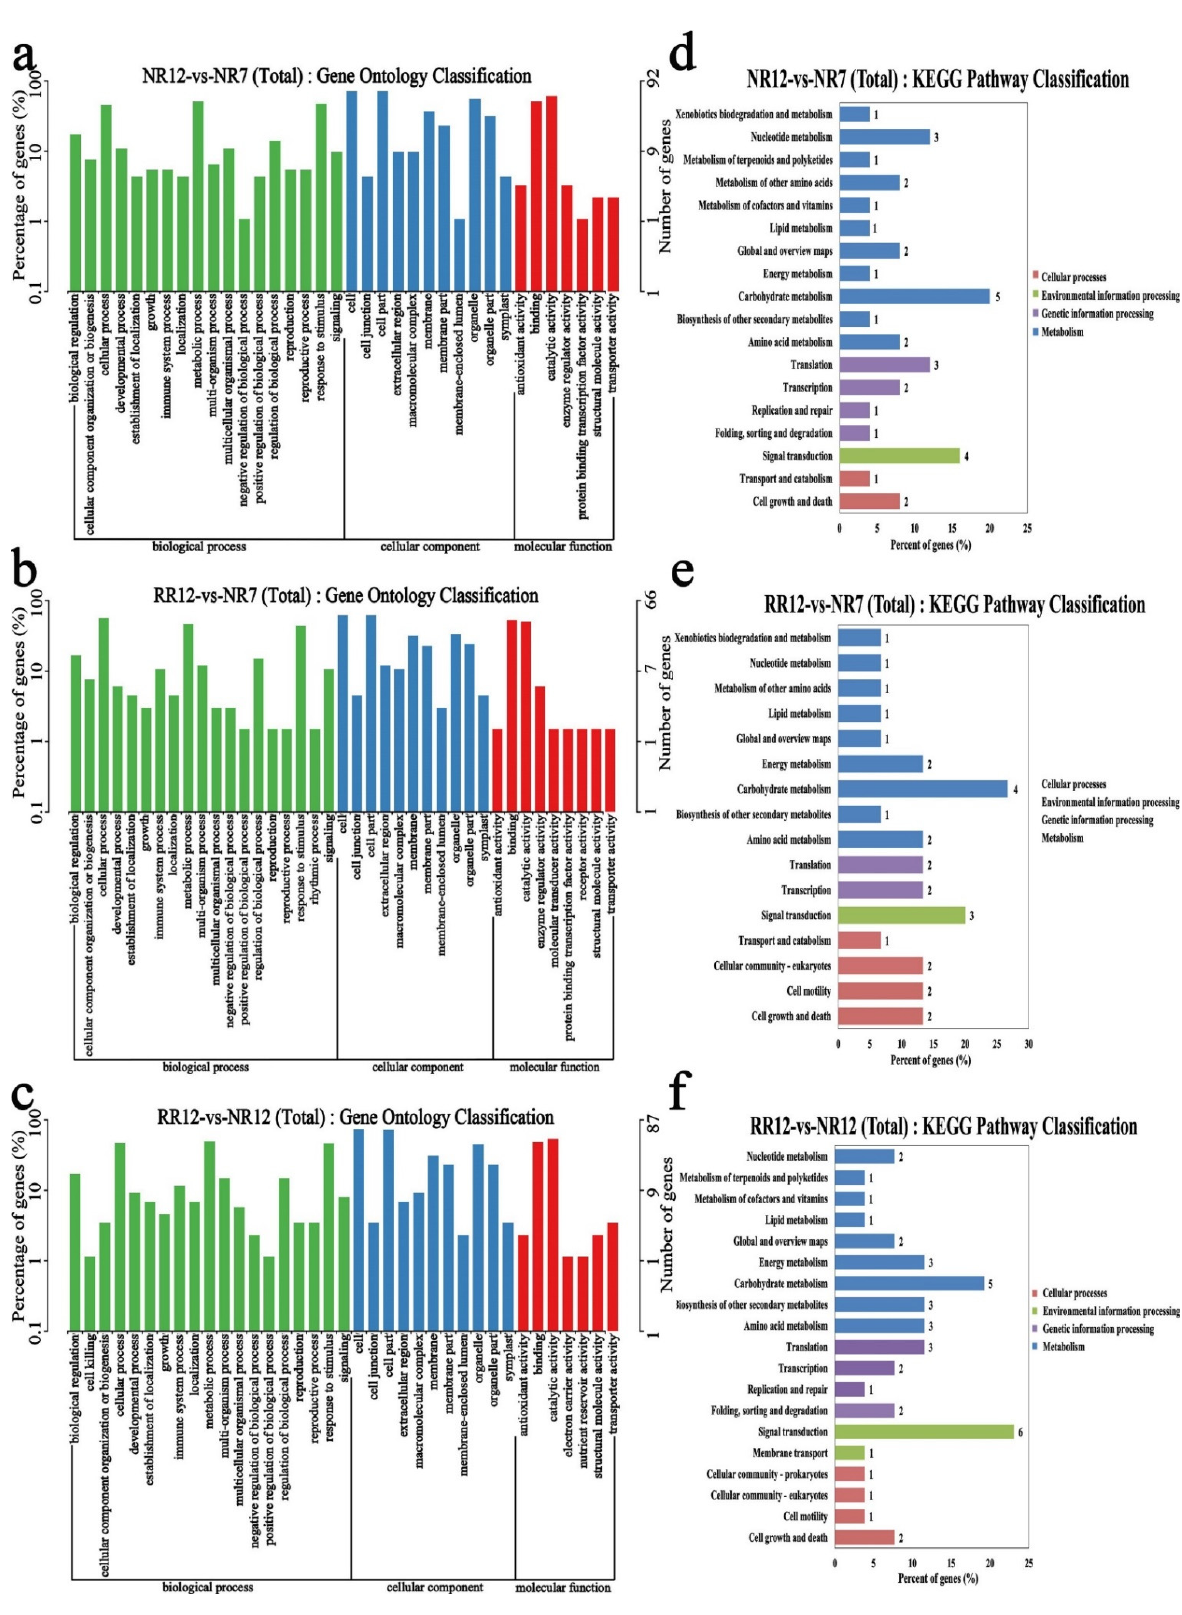
Figure 7. The functional analysis results of neighboring genes of differentially expressed